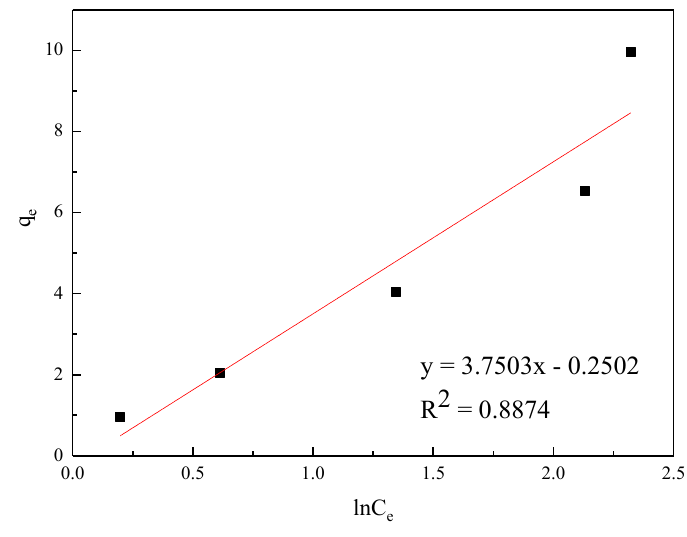
Figure 16. Linear regression of the Temkin isotherm model (298 K). Table 6. Constants and correlation coefficients of the Langmuir, Freundlich, and Temkin isotherm models for pyridine adsorption on coke powder.